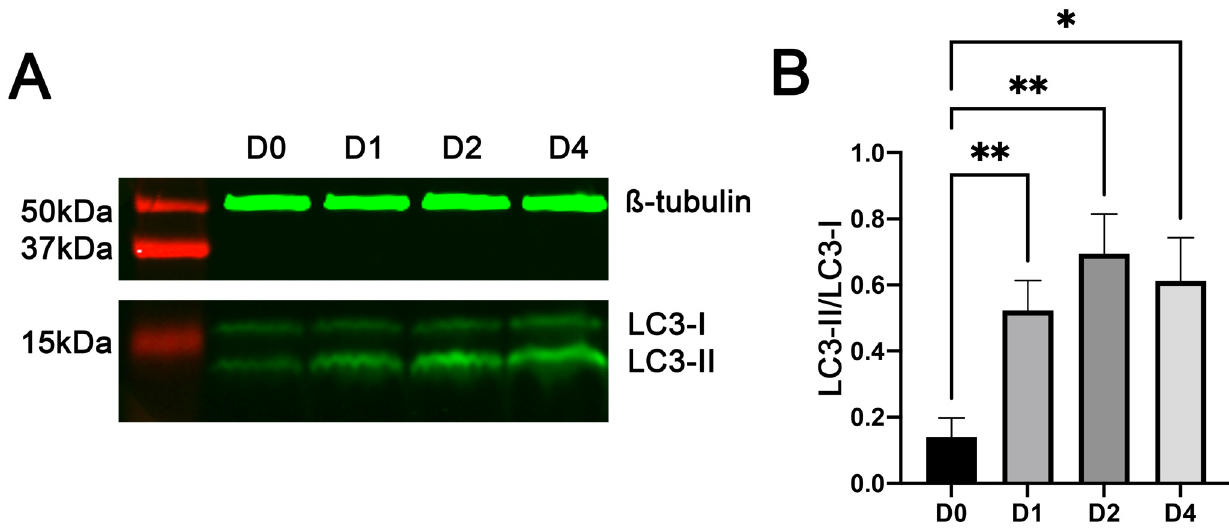
Figure 3. Increased generation and accumulation of LC3-II in C2C12 cells during myogenic differ- entiation. Total protein lysates from C2C12 cells on day (D) 0 (i.e., before differentiation) and days 1, 2, and 4 of myogenic differentiation were analyzed by Western blotting. ( A ) Representative images of Western blots. ( B ) Average ratios of LC3-II to LC3-I protein. * and ** indicate p < 0.05 and <0.002, respectively ( n = 6), based on Dunnett’s test.